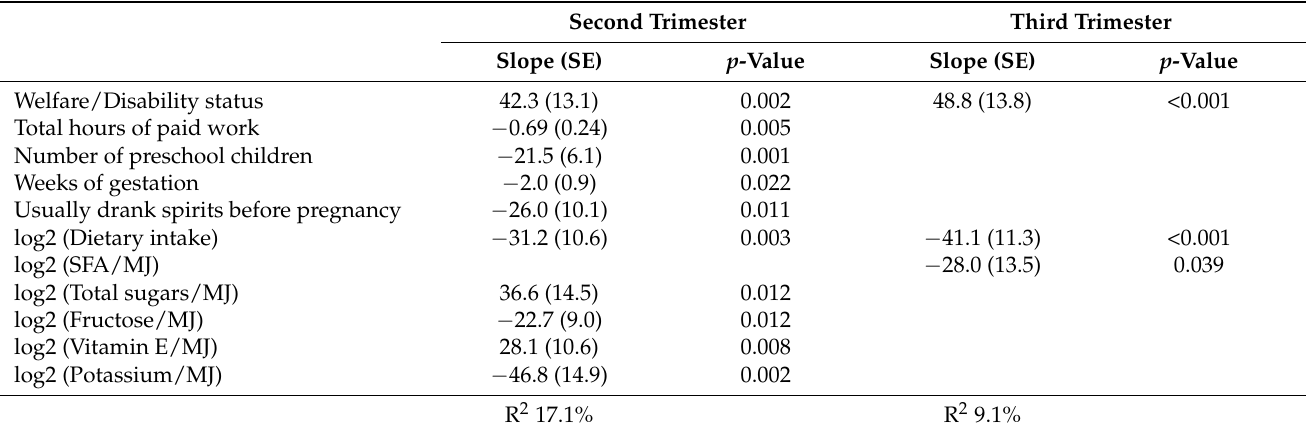
Table 4. Multivariate regression for minutes of TIB in the second and third trimester combining confounders and nutrient